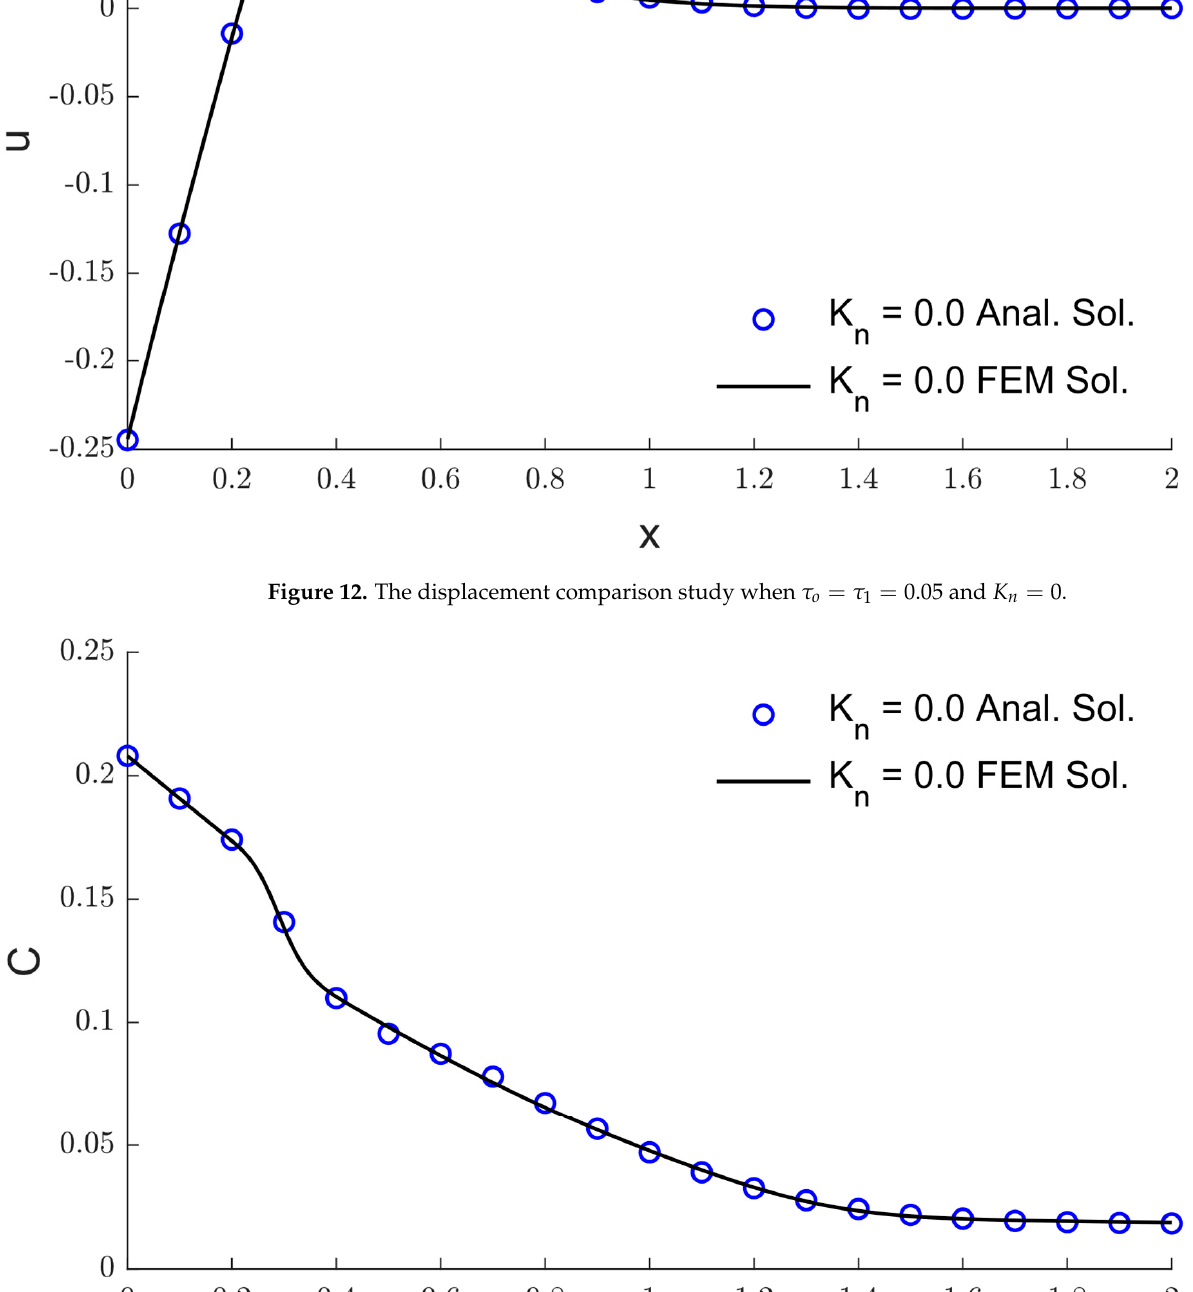
Figure 13. The concentration comparison study when τ o = τ 1 = 0.05 and K n = 0 .